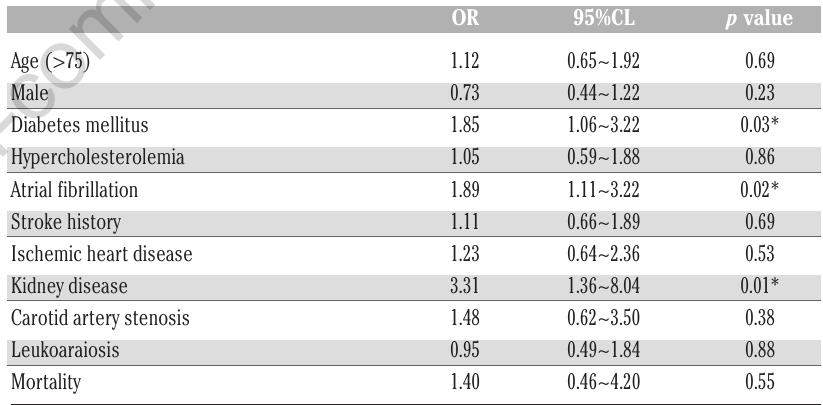
Table 2. Odds ratio for an association of risk factors with the presence of a high blood